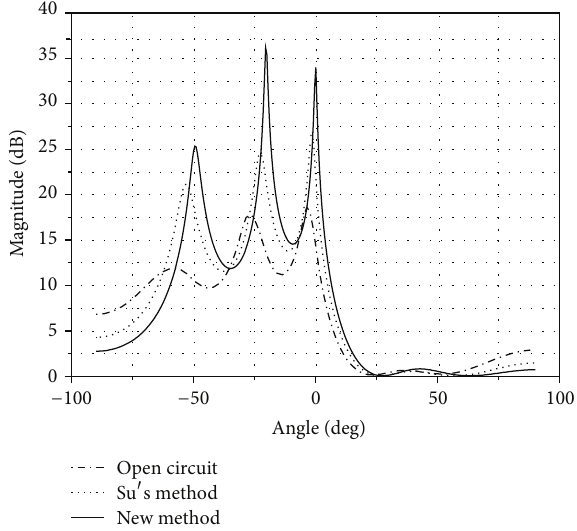
Figure 9: Average spatial spectra due to the new method, the open circuit voltage method, and Su’s method.